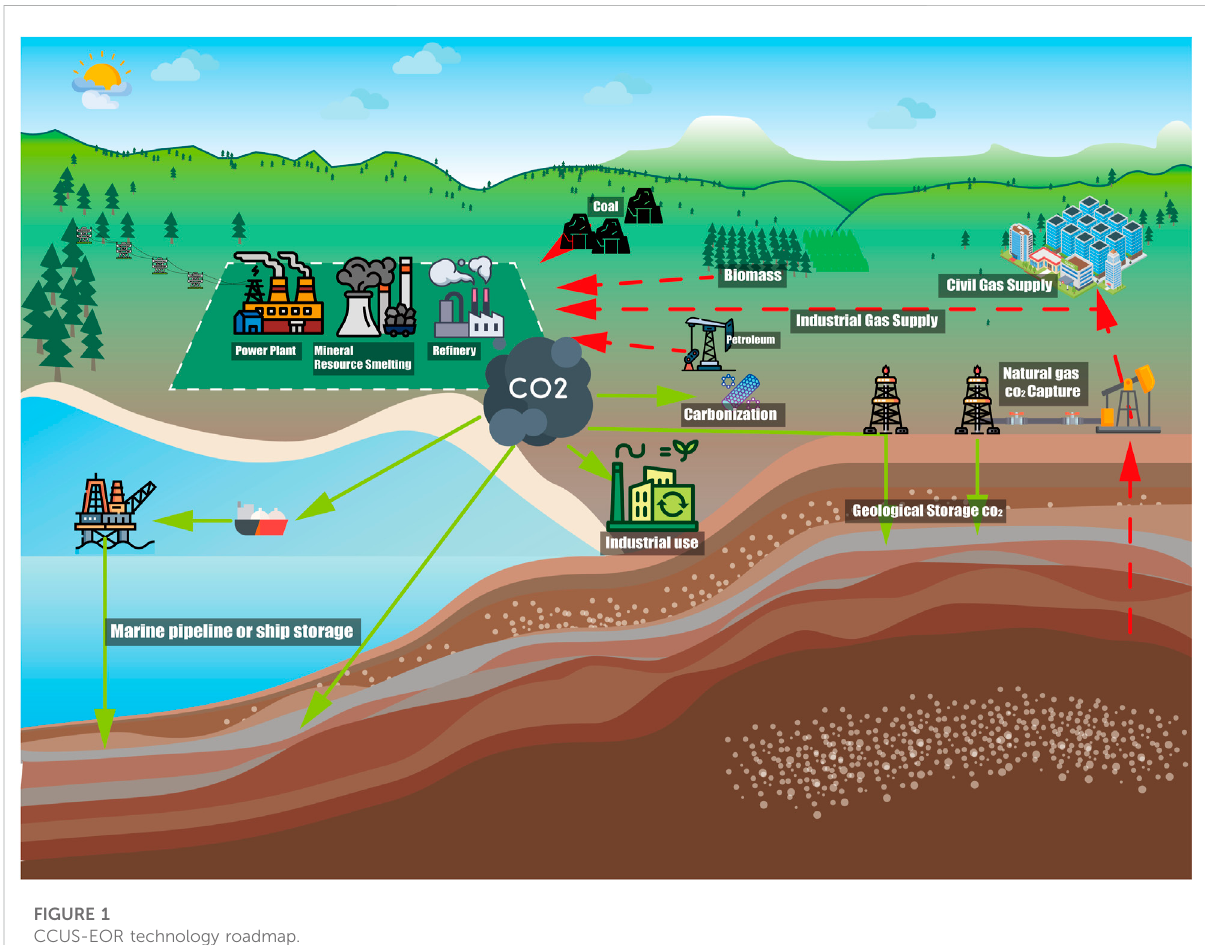
FIGURE 1 CCUS-EOR technology